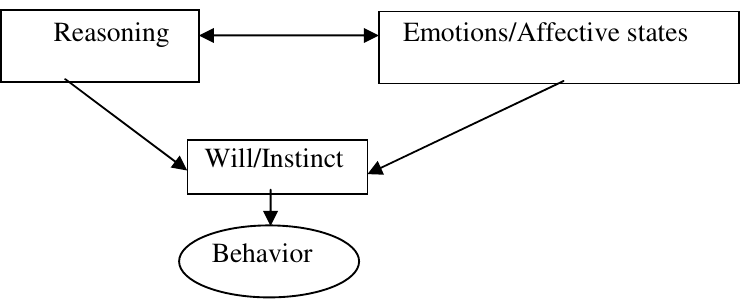
Figure 1. Interaction between components of personality. Reasoning Emotions/Affective states